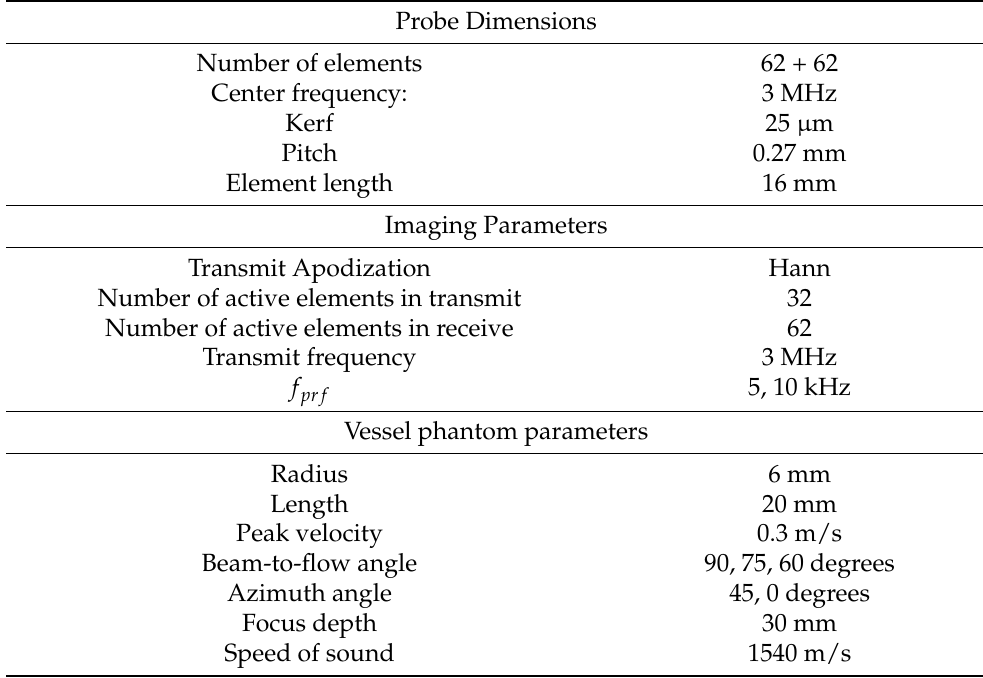
Table 1. Probe parameters and Imaging